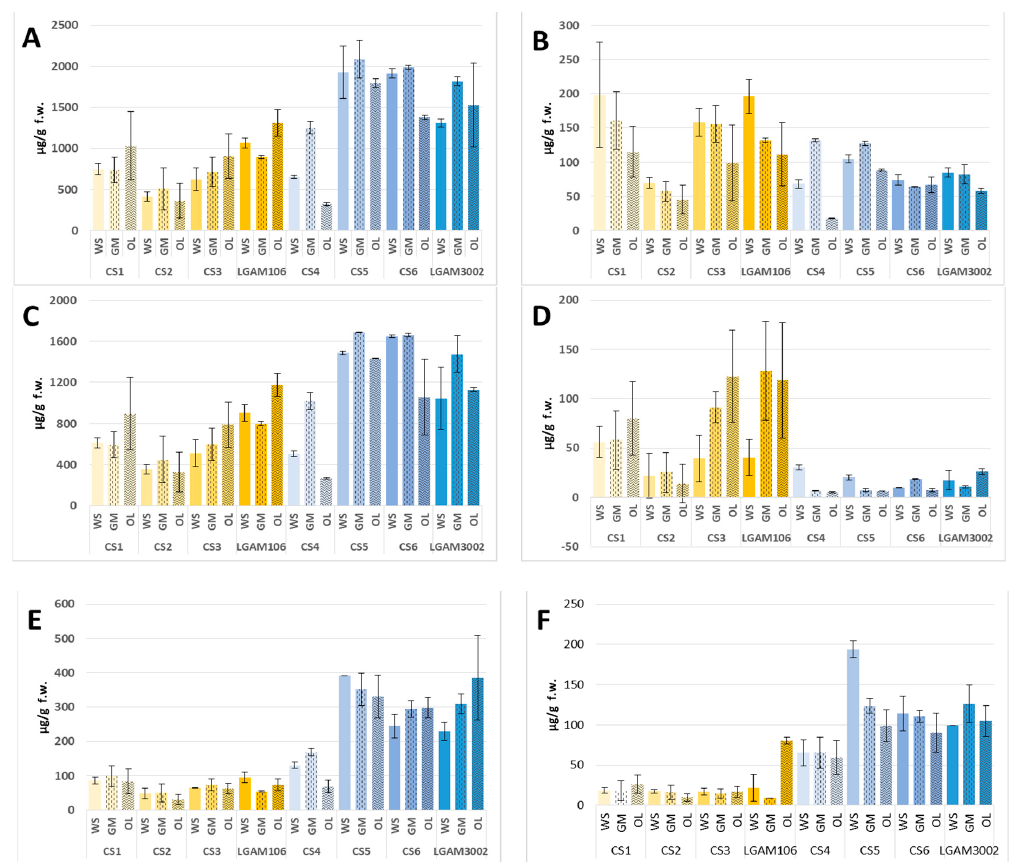
Figure 1. Main volatile classes ( µ g/g f.w. equivalents of 4-methyl-2-pentanol) in eight strains of P. eryngii and P. ostreatus grown on three cultivation substrates. ( A ) Eight carbon atoms compounds, ( B ) aldehydes, ( C ) alcohols, ( D ) FAME, ( E ) ketones, ( F ) toluene. Abbreviations f.w.; fresh weight, n.d.: not detected, CS: commercial strains; LGAM: Laboratory of General and Agricultural Microbiology (Agricultural University of Athens, Greece); FAME: fatty acid methyl esters; WS: wheat straw; GM: wheat straw with grape marc (1:1 w / w ); OL: olive leaves with olive mill wastes (3:1 w / w ).